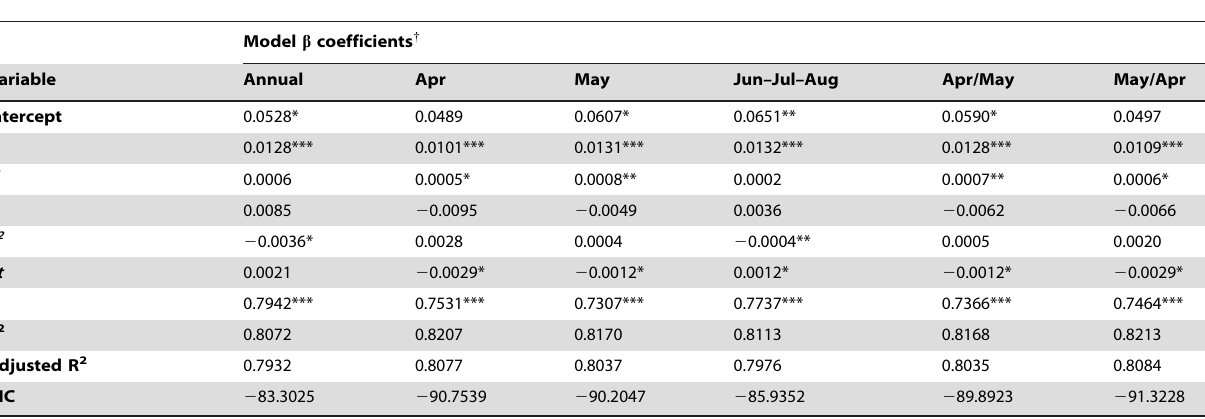
Table 1. Trend surface models of 2005 district-level JE incidence as a function of temperature and